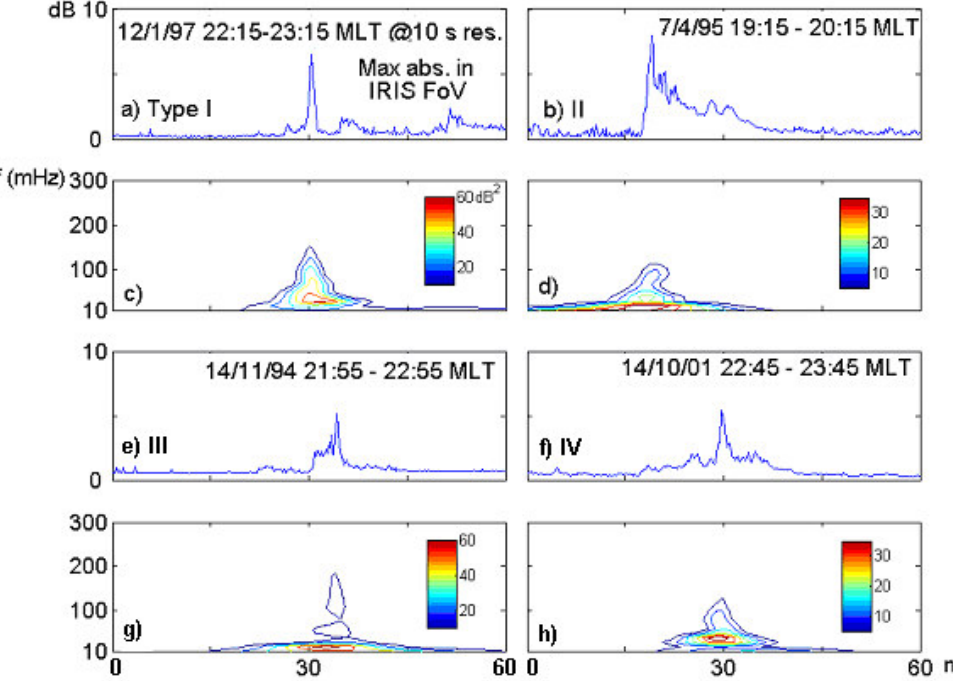
Fig. 6. Wavelet spectrum of 4 types of spike events. Panels (a) , (b) , (e) and (f) are maximum absorption in IRIS FoV in dB at 10-s resolution. Panels (c) , (d) , (g) and (h) are corresponding wavelet spectrum, respectively. Colorbar contours are in dB 2 and the range of frequency is between 10 and 300mHz. Data in all panels have 1-h period (x